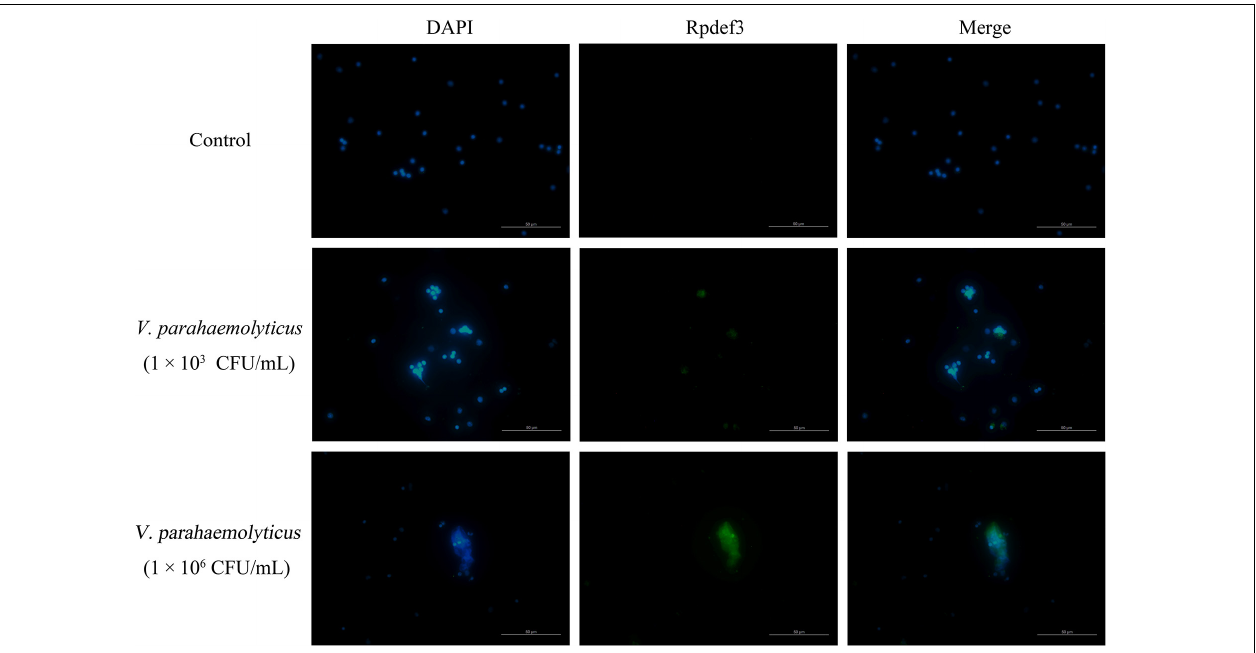
FIGURE 2 | Immunostaining of DNA traps and Rpdef3. Clam hemocytes were treated with V. parahaemolyticus (1 × 10 3 and 1 × 10 6 CFU/mL) for 1 h and stained for DNA (blue) and defensin (green). Bar, 100 µ